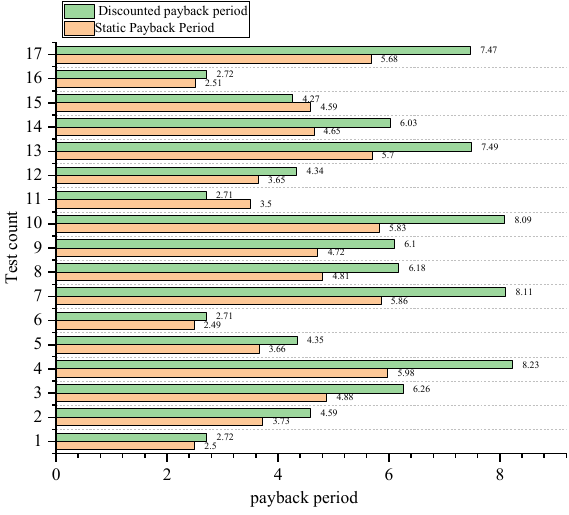
Figure 9. Payback period table.